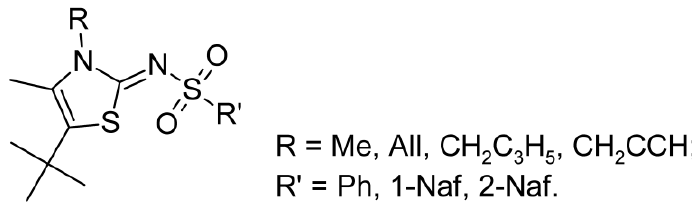
Figure 2. General chemical structure of selective hCB2R agonists.